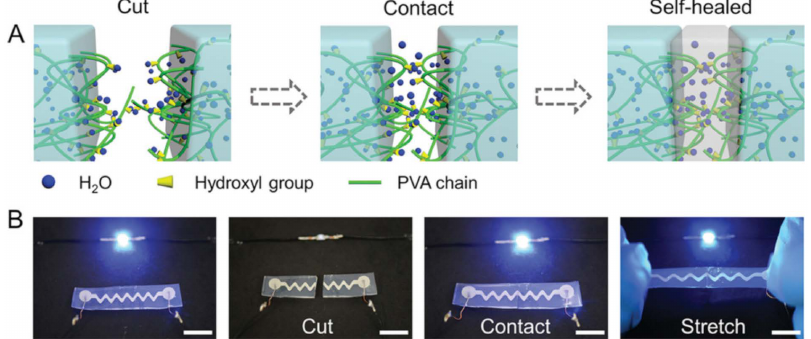
Figure 4. Self-healing of the LM-based hydrogel electronics. ( A ) Schematic illustration of the self-healing process of the PVA hydrogel. ( B ) Photographs of the LM–hydrogel device before and after cutting. The self-healed device under stretching is also shown. Scale bars: 1 cm. Reproduced from [114] with permission from John Wiley and